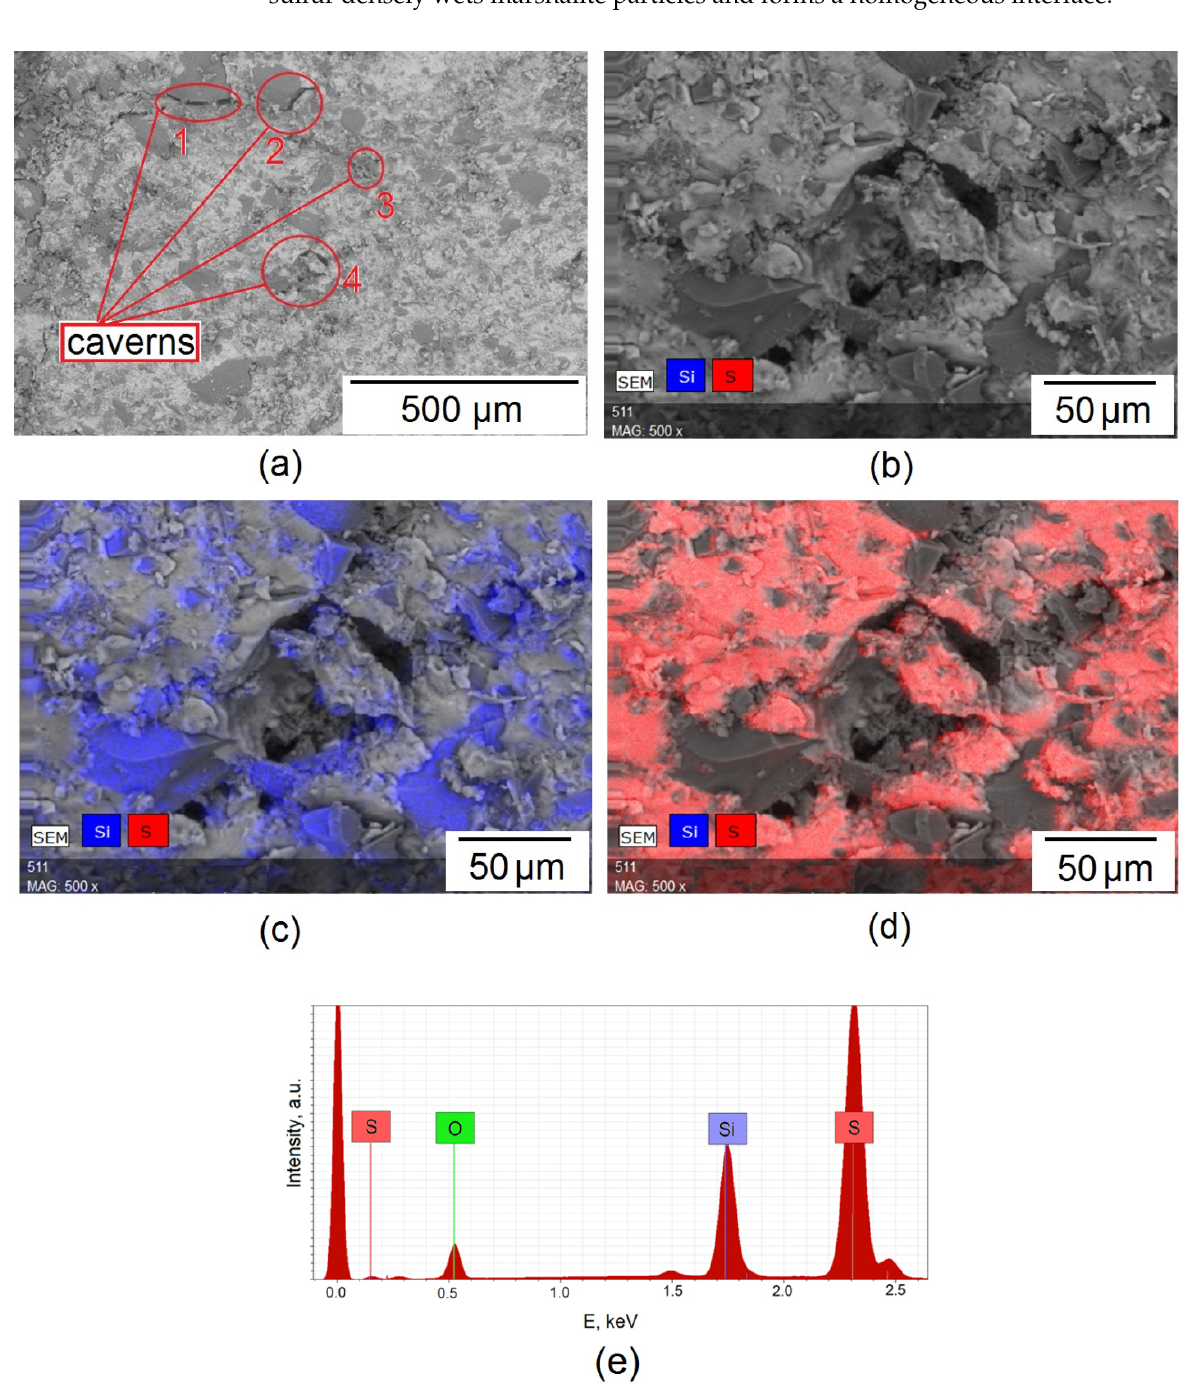
Figure 5. Micrographs of the sulfur/marshalite composite (50/50), in the figure ( a ) caverns formed as a result of shrinkage are marked, ( b ) the cavern is approximated, ( c ) the distribution of silicon, ( d ) the distribution of sulfur, the results of ( e ) X-ray luminescence analysis. (2-column fitting image).